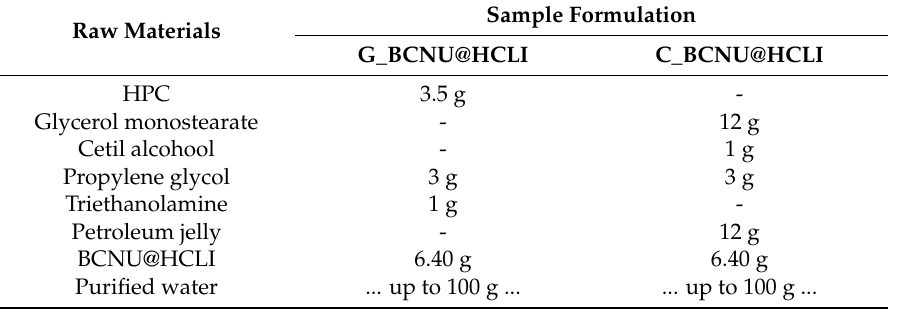
Table 10. Formulations of semisolid dosage forms with BCNU@HCLI: composition and abbreviation. Raw Materials